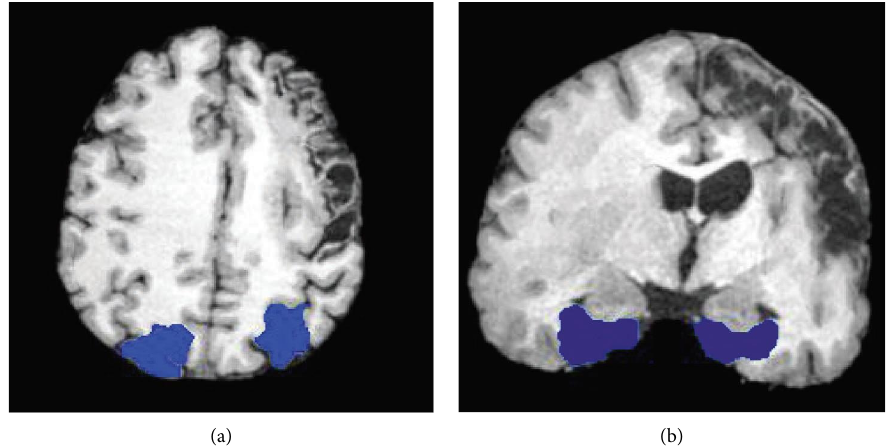
Figure 2: Te results of VBM showed the increased gray matter volume in the observation group compared with the control group. (a) Te MRI axial image, and (b) the MRI coronal image. Te blue areas in the fgure represented areas of the increased gray matter volume.